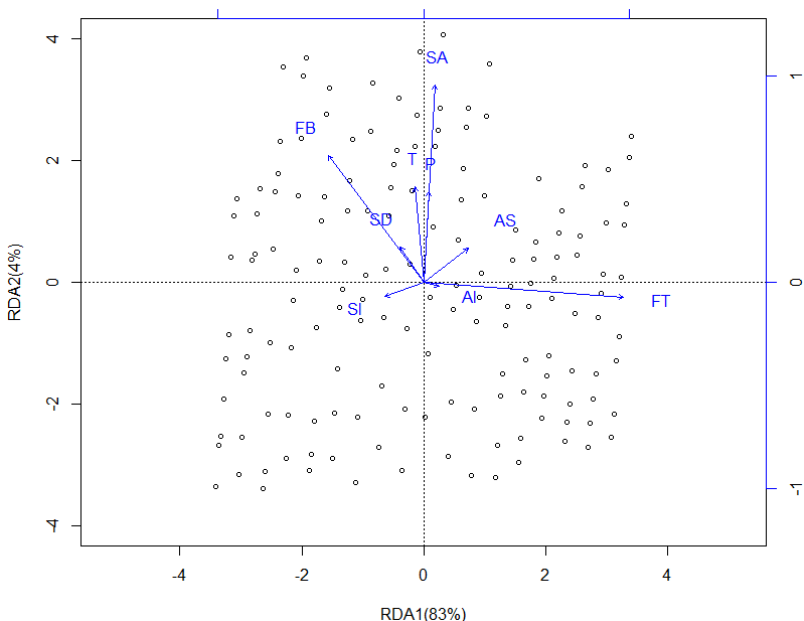
Figure 7. Redundancy Analysis (RDA) showing the relationships between the CWD mass and effect factors in the different samples on the Huoditang Experimental Forest Farm in the Qinling Mountains (China). Arrows indicate effect factors: FT = Forest type; FB = Forest biomass; AS = Aspect; Al = Altitude; SA = Stand age; Sl = Slope; SD = Stand density; T = Annual average temperature; P = Annual average precipitation.